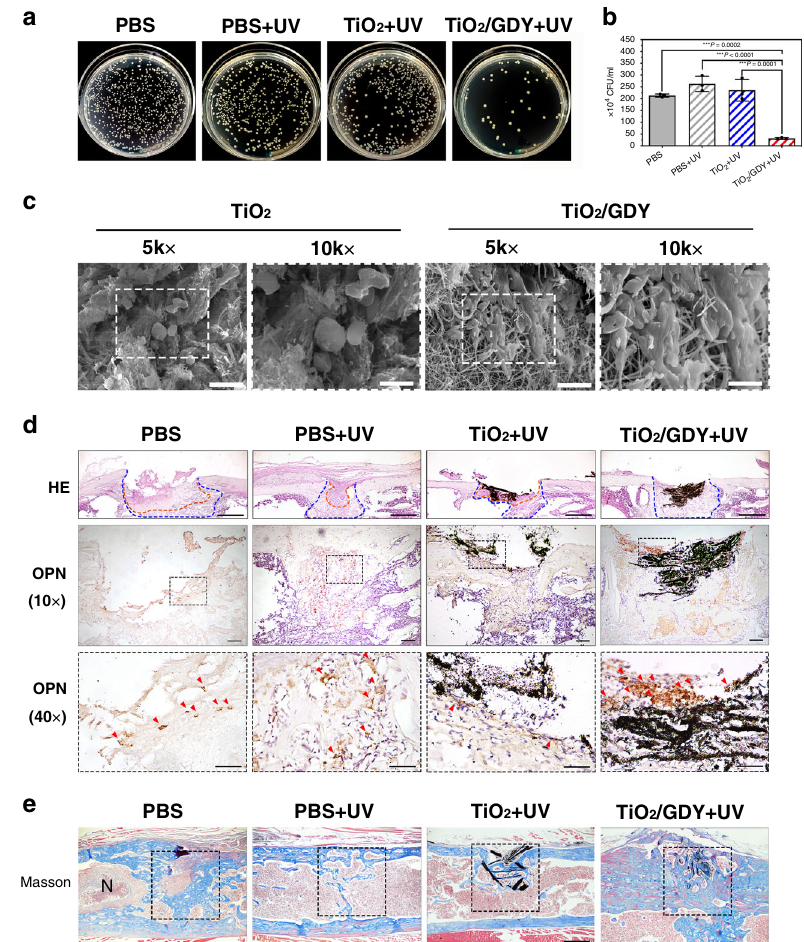
Fig. 5 Antibacterial and osteogenic effects of TiO 2 /GDY in vivo. a , b Photographs and quantitative analysis of the bacterial colonies of the infected femurs treated with TiO 2 , TiO 2 /GDY, or PBS as a control, with UV irradiation (365 nm, 2 W cm − 1 , 5 min). The data are shown as the mean ± S.D., error bars = Standard Deviation ( n = 3 biological independent samples, one-way ANOVA was applied for statistical analysis, * p < 0.05; ** p < 0.01; *** p < 0.001). c SEM images of the mouse femur tissues with TiO 2 or TiO 2 /GDY nano fi ber implantation after 5 days, with ×5000 (left) and ×10,000 (right) magni fi cation, scale bar = 10 μ m (left), 5 μ m (right). ( n = 3 biological independent samples). d H&E staining and immunohistochemical staining of infected tissues after 5 days. Orange dotted lines in the H&E images represent infectious and necrotic areas; between the orange and blue dotted lines are new bone formation areas (scale bar = 500 μ m). OPN 40×: scale bar = 50 μ m; OPN 10×: scale bar = 100 μ m, and red arrowheads point out OPN-positive osteoblasts. ( n = 3 biological independent samples). e Masson staining for bone formation after 4 weeks (scale bar = 500 μ m). “ N ” in the PBS image represents the necrotic tissue in the bone marrow. ( n = 3 biological independent samples.) Source data of ( b ) are provided as a Source Data fi